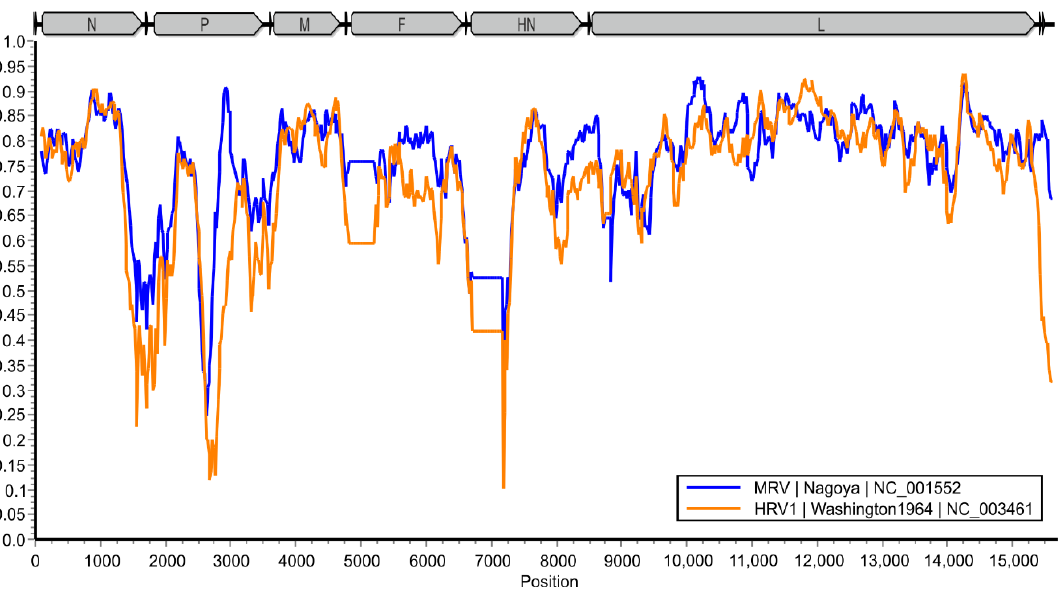
Figure 4. Similarity analysis of the GSqRV genome to MRV and HRV1 using SimPlot. The sequence identity within a sliding window of 200 nt centered on the plotted position is depicted, with a step size of 20 nt.